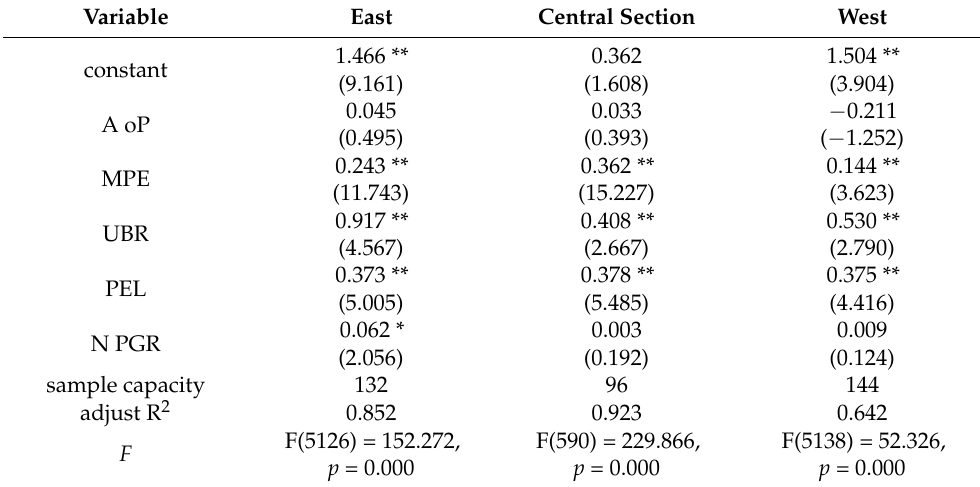
Table 10. Results of sub-sample regression of the mediation effect of health